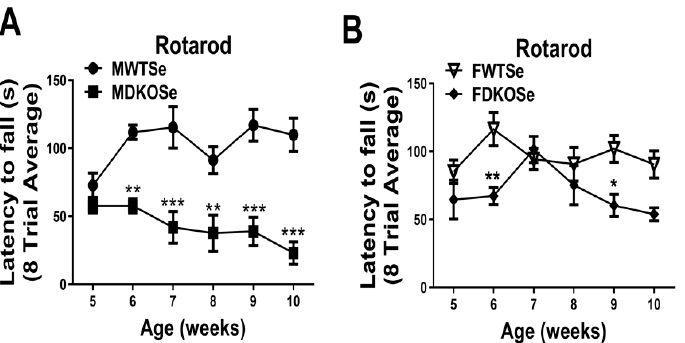
Figure 1. Rotarod performance in wild-type mice supplemented with Se (WTSe) and double knockout mice supplemented with Se (DKOSe). ( A ) Latency to fall of male WTSe and DKOSe mice from 5 to 10 weeks of age. ( B ) Latency to fall of female WTSe and DKOSe mice from 5 to 10 weeks of age. (Rotarod two-way ANOVA: Males interaction F (5,60) = 3.12, p = 0.0145, Genotype F (1,60) = 102.44, p < 0.0001, week NS; Females interaction NS, Genotype F (1,60) = 19.08, p < 0.0001, week NS; n = 6 all groups. Bonferroni’s: * p < 0.05, ** p < 0.01, *** p < 0.001). All values reported as Mean ± SEM.